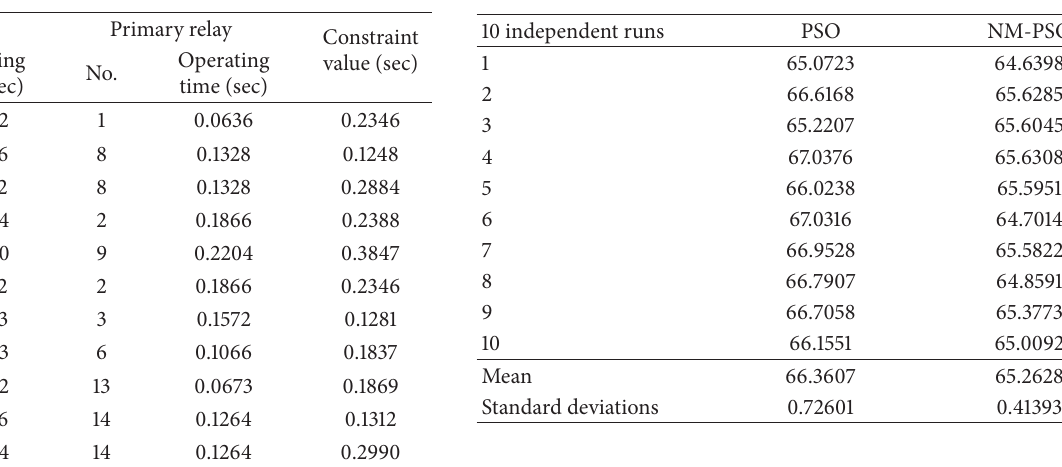
Table 5: Operation times of primary/backup relay pairs after the removal of Line 65 (near-end faults).